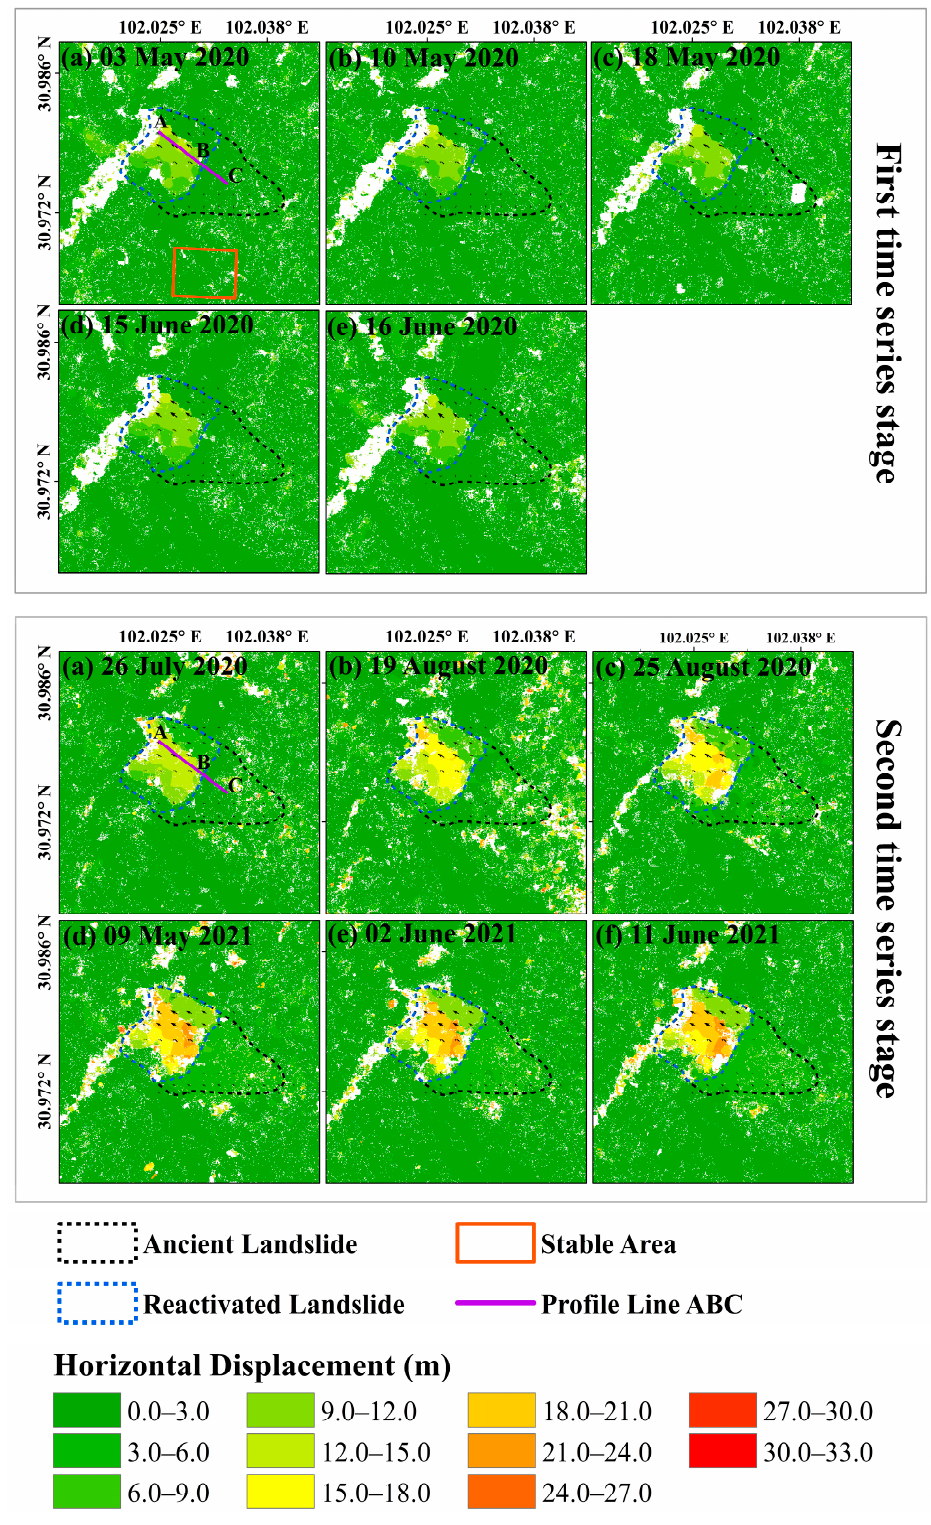
Figure 7. Selected POT time series displacements from 3 May 2020 to 11 June 2021, including ( a – e ) on the top for the first time series stage (3 May 2020 to 16 June 2020) and ( a – f ) at the bottom for the second time series stage (26 July 2020 to 11 June 2021). Note that only the image pairs with limited sun illumination differences (SED ≤ 10 ◦ and SAD ≤ 20 ◦ ) are used. Black arrows represent the directions of horizontal